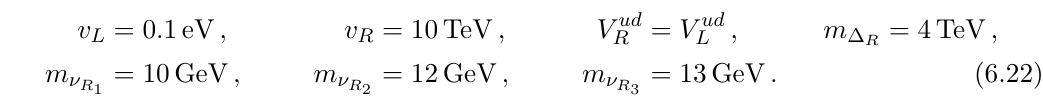
as a function of the lightest neutrino mass for (cid:12)(cid:12) = 0, is depicted by the red line. The lower-left (cid:23) m e(cid:11) =m (cid:12)(cid:12) 1, for the normal and inverted hierarchy, (cid:12)(cid:12) j j (cid:0) in blue (cid:12)(cid:12)